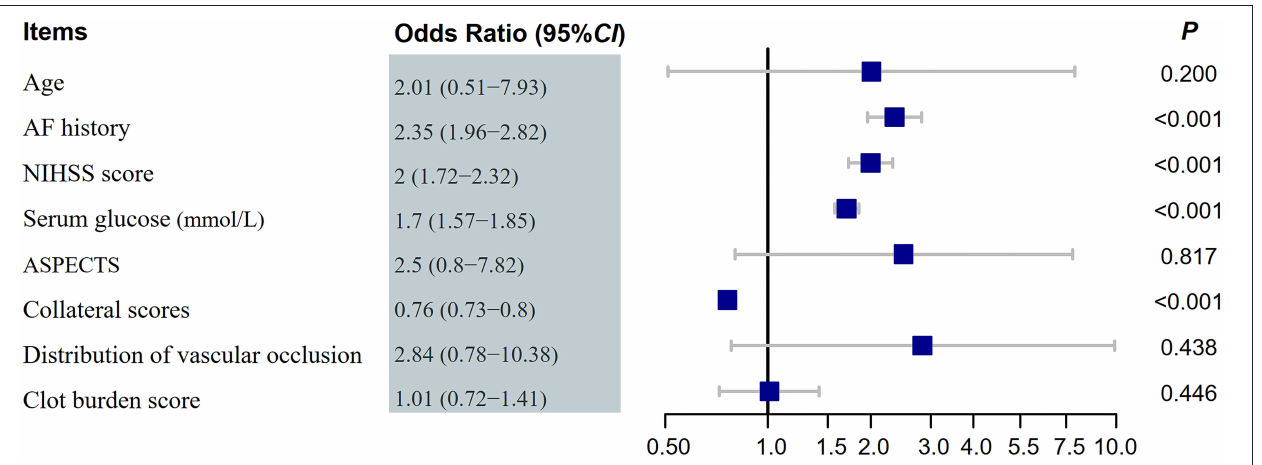
Frontiers in Neurology |